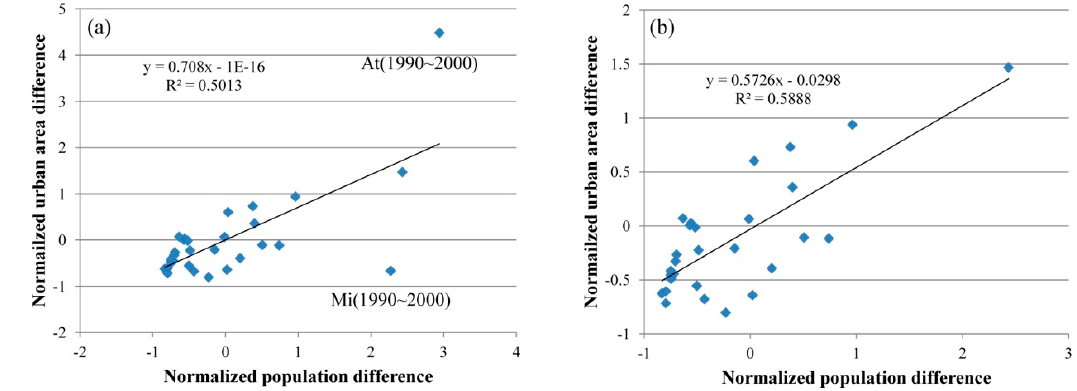
Figure 8. Changes of growth rate of population and urban areas in 15 largest metropolitan areas in the Southeast U.S.A. from 1990 to 2010. ( a ) All metropolitan areas were analyzed; and ( b ) changes in At and Mi metropolitan areas for 1990–2000 period were excluded.